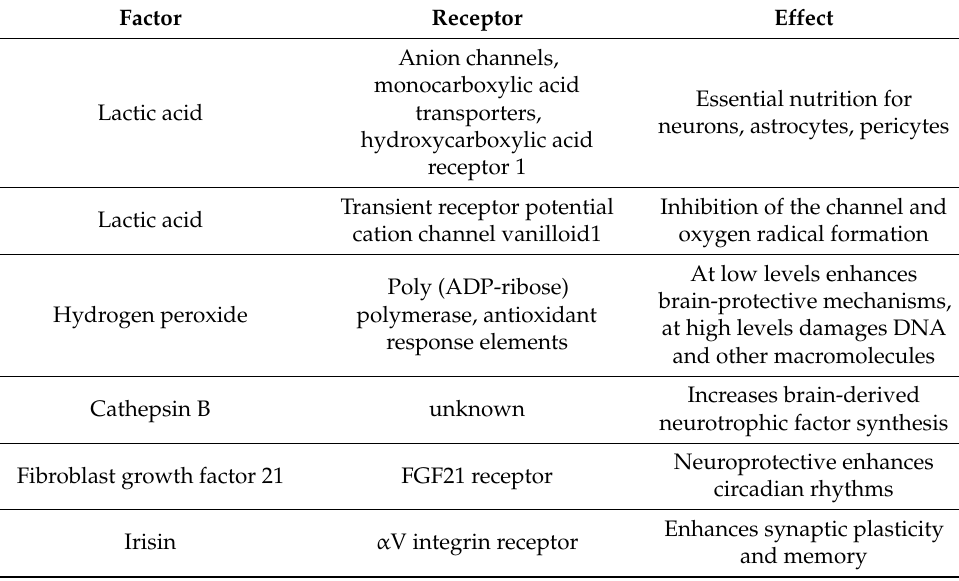
Table 1. Brain muscle axis. The effects of exercise on the brain and the blood–brain